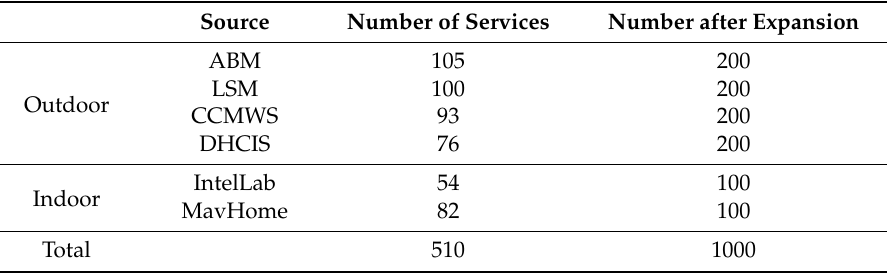
Table 1. Service